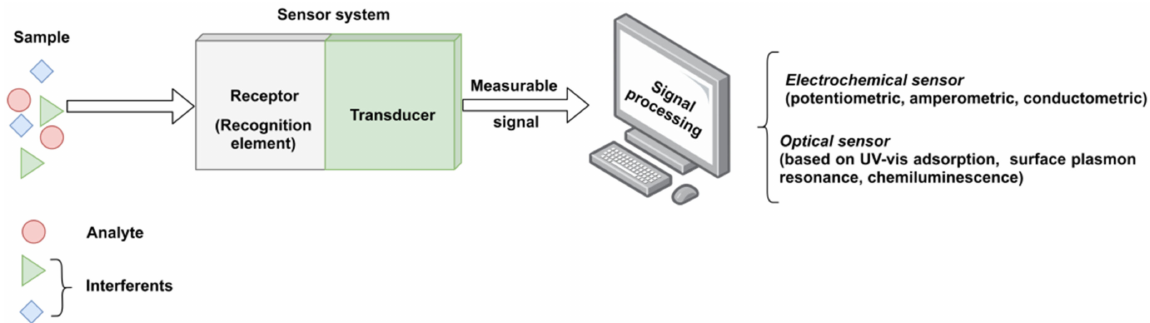
Figure 1. The functional scheme of a typical sensor system.